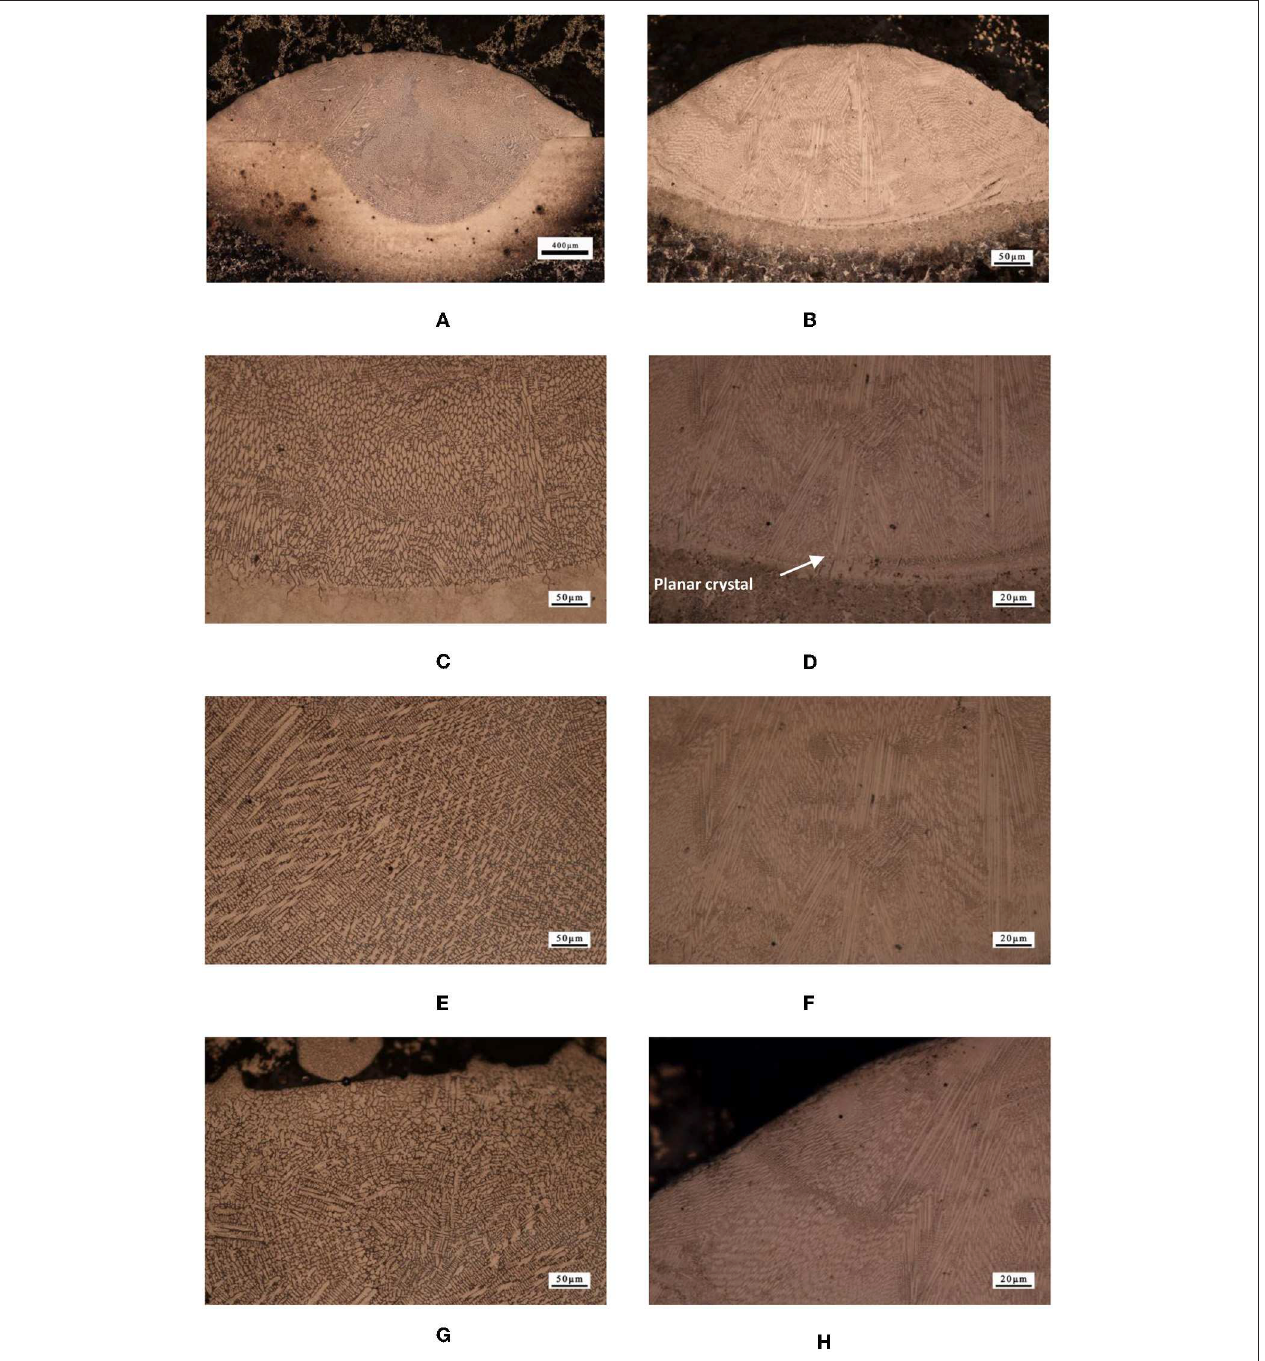
FIGURE 3 | Microstructure of single-track layers. (A) Morphology of the LMD layer; (B) morphology of the EHLMD layer; (C) bottom of the LMD layer; (D) bottom of the EHLMD layer; (E) middle of the LMD layer; (F) middle of the EHLMD layer; (G) top of the LMD layer; (H) top of the EHLMD layer.